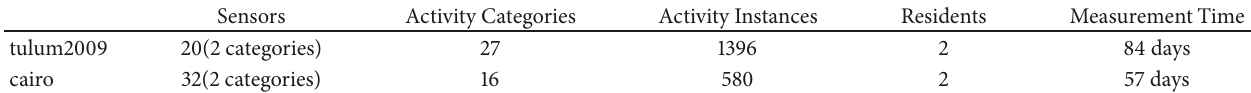
Table 1: Statistical information concerning datasets “tulum2009” and